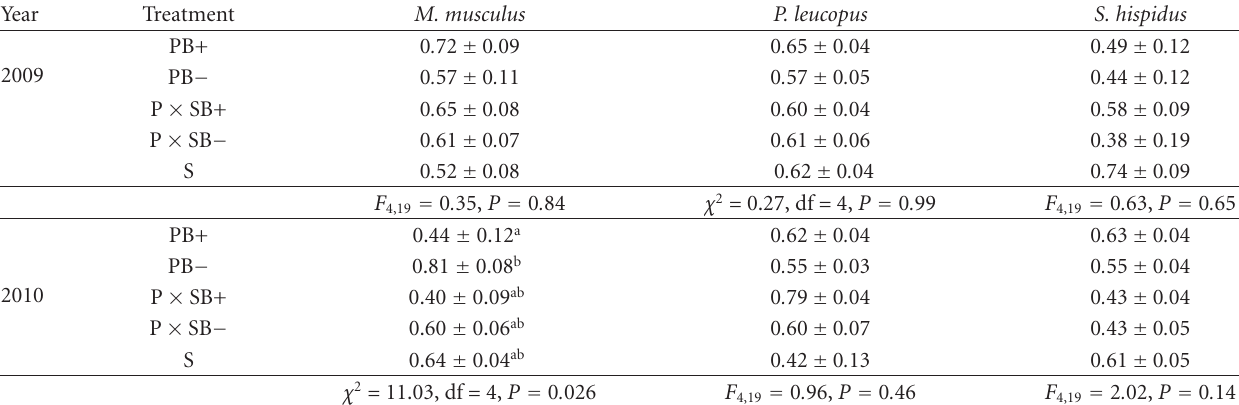
Table 4: Mean ( ± 1SE) values of sex ratio (proportion males) from adult population abundance estimates calculated in Program MARK. Rodents were captured and released on site at the Lenoir 1 Sustainability Study Site, in Lenoir Co., NC, during 15 July–9 December, 2009 and 19 July–14 November, 2010. Statistical results are from comparisons using a 1-way ANOVA or Kruskal-Wallis test when parametric assumptions were not met. Kruskal-Wallis test statistics are reported as χ 2 estimates. Within a year-species pairing, means with di ff erent letters are significantly di ff erent from one another (Mann-Whitney U pairwise comparisons with Bonferroni correction). Treatments: PB+ = Pine Biomass+; PB − = Pine Biomass − ; P × SB+ = Pine × Switchgrass Biomass+; P × SB − = Pine × Switchgrass Biomass − ; S =